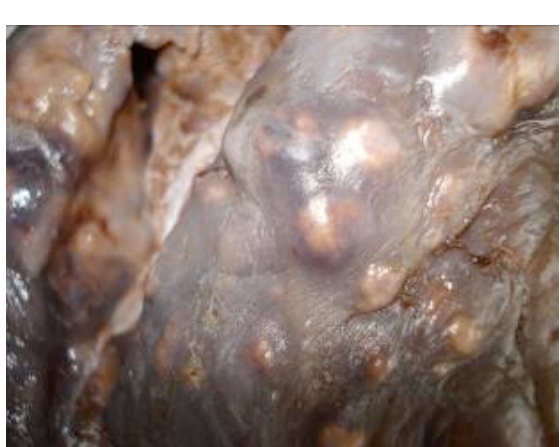
Image 1. Lung of Spotted Deer showing caseous nodules and black-brown coloration